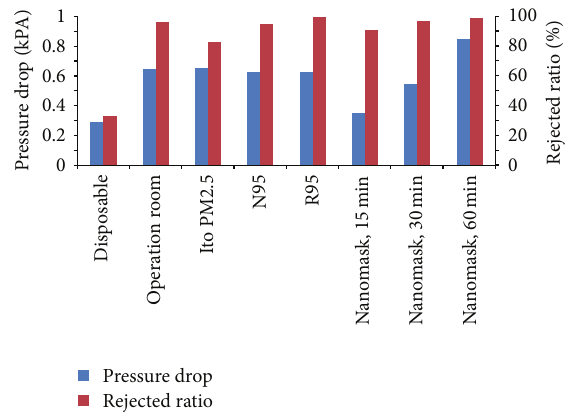
Figure 4: Permeability and intercept rate comprehensive compari-